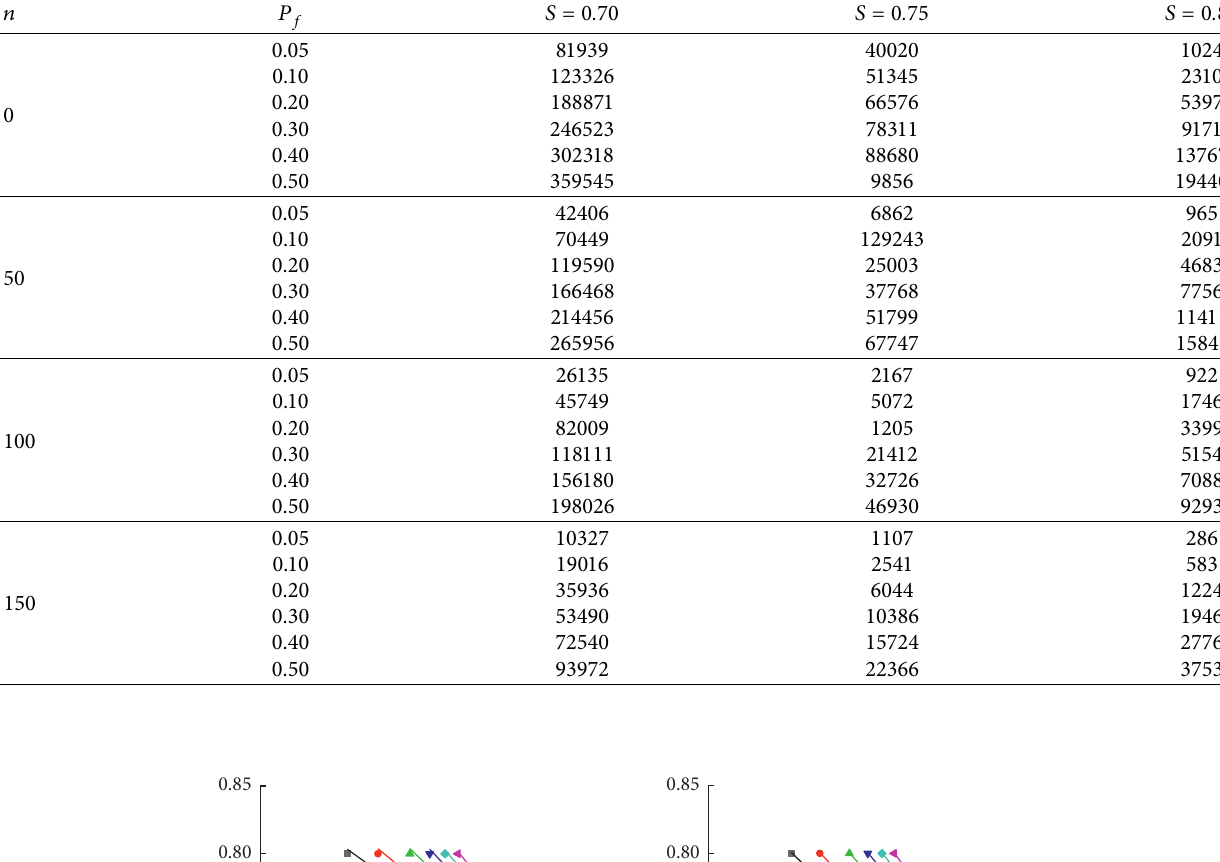
Table 11: Flexural fatigue life ( N p ) of AASC for various failure